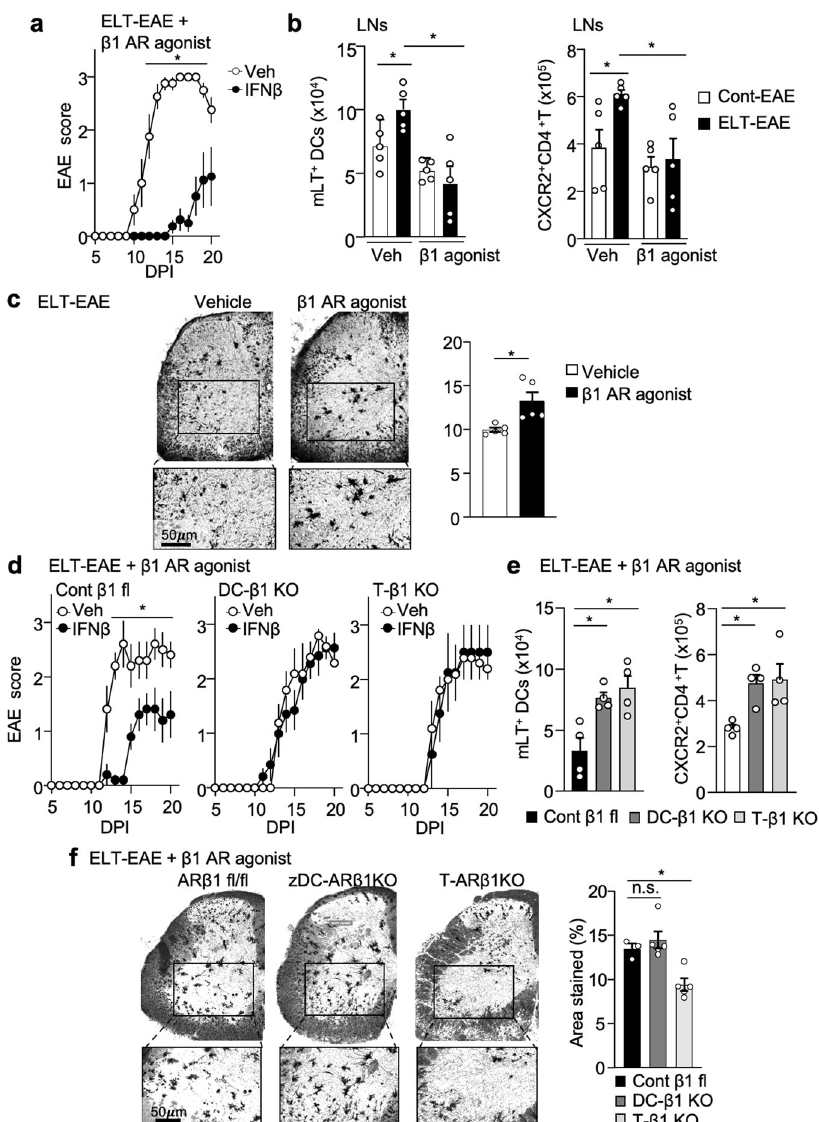
Fig. 8 β 1-AR agonist treatment is suf fi cient to rescue ELT-EAE subtype. a EAE scores of IFN β -treated ELT-EAE mice subjected to β 1-AR agonist (Xamoterol, 3 mg/kg) treatment (ELT- β 1-AR agonist-Veh: n = 4, ELT- β 1-AR agonist-IFN β : n = 8). Interferon- β was treated from 0 to 9 dpi once every 3 days. Xamoterol was treated from 0 to 10 dpi every other day. b Absolute number of mLT-expressing lymph node DCs and CXCR2-expressing CD4 + T cells from EAE mice with β 1-AR agonist or vehicle treatment ( n = 5 animals/group). c Golgi – Cox-stained lumbar spinal cord sections of ELT-EAE mice treated either with vehicle or with β 1-AR agonist isolated at 30 dpi with quanti fi cation of area stained/per fi eld ( n = 5 animals/group). d EAE scores of IFN β -treated control β 1-AR fl ELT-EAE mice, dendritic cell (DC)-speci fi c β 1-AR knockout ELT-EAE mice, and T cell-speci fi c β 1-AR knockout ELT-EAE mice subjected to β 1-AR agonist (Xamoterol, 3 mg/kg) treatment (ELT- β 1-AR agonist-Cont-Veh: n = 5, ELT- β 1-AR agonist-Cont-IFN β : n = 5, ELT- β 1-AR agonist-DC- β 1KO-Veh: n = 5, ELT- β 1-AR agonist-DC- β 1KO-IFN β : n = 7, ELT- β 1-AR agonist-T- β 1KO-Veh: n = 5, ELT- β 1-AR agonist-T- β 1KO-IFN β : n = 5). Interferon- β was treated from 0 to 9 dpi once every 3 days. Xamoterol was treated from 0 to 10 dpi every other day. e Absolute number of mLT-expressing lymph node DCs and CXCR2- expressing CD4 + T cells from control β 1-AR fl ELT-EAE mice, DC-speci fi c β 1-AR knockout ELT-EAE mice, and T cell-speci fi c β 1-AR knockout ELT-EAE mice subjected to β 1-AR agonist (Xamoterol, 3 mg/kg) treatment ( n = 4 animals/group). f Golgi – Cox-stained lumbar spinal cord sections of β 1-AR agonist treated ELT-EAE mice of different transgene knockout conditions at 30 dpi with quanti fi cation of area stained/per fi eld (ELT- β 1-AR agonist-Cont: n = 3, ELT- β 1-AR agonist-DC- β 1KO: n = 5, ELT- β 1-AR agonist-T- β 1KO: n = 5). Male mice were used for experiments. Each dot represents averaged data per animal. Data are represented as mean ±SEM. Student ’ s t -test, * P < 0.05. Exact P values for asterisks (from left to right): a 0.0027; b 0.0258, 0.0131, 0.0223,